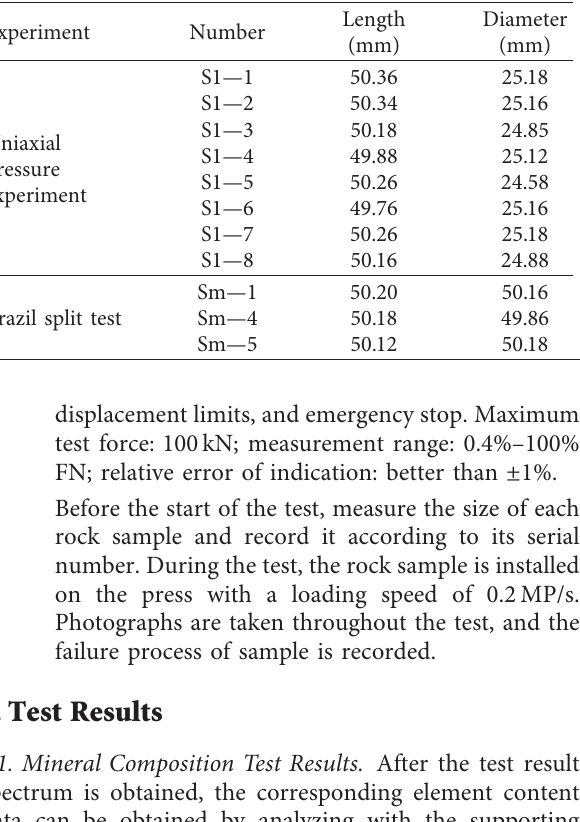
Table 1: Deep sandstone sample number and